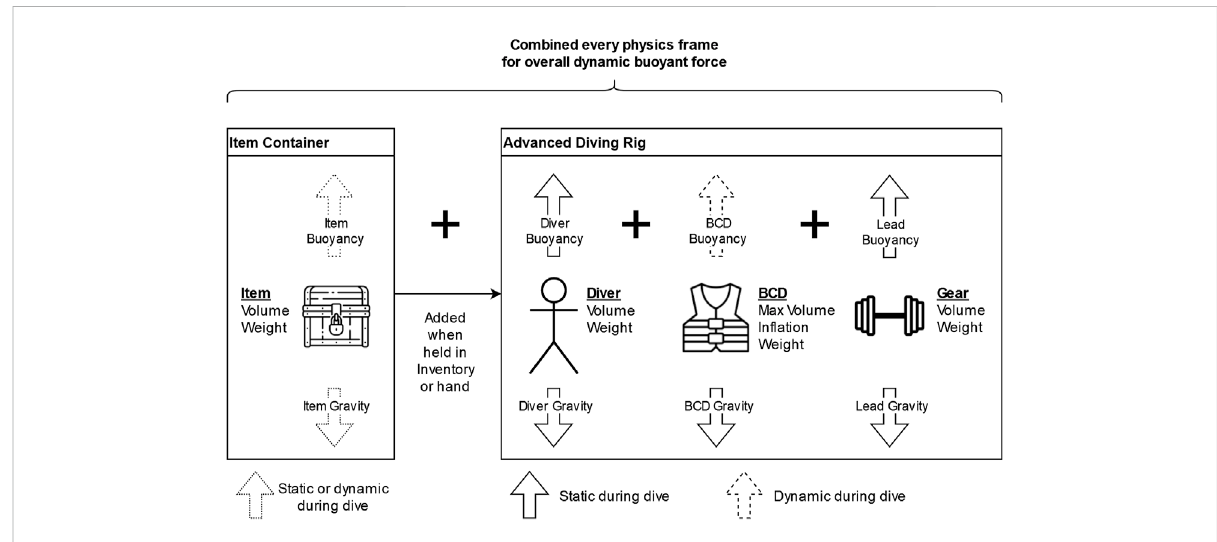
FIGURE 2 The different forces in fl uencing the overall buoyant force applied to the player